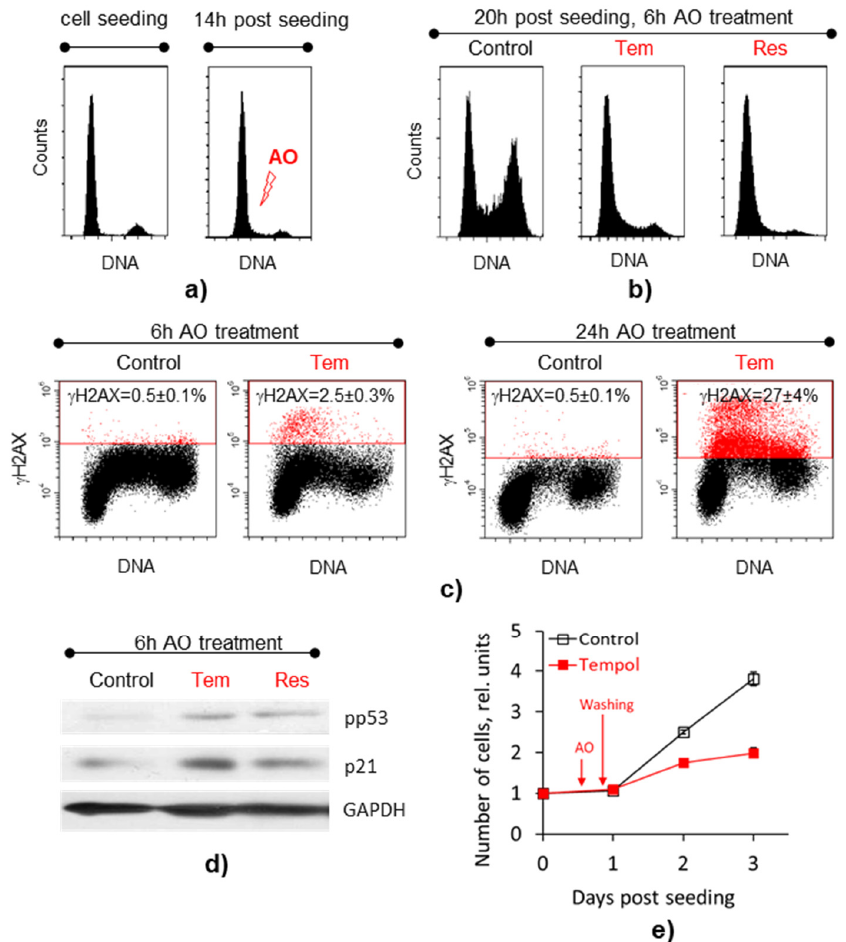
Figure 1. Cells treated with antioxidants in the early S phase slow down the DNA synthesis, accumulate DNA damage and lose proliferation capacity: ( a ) cell cycle distributions of synchronized MSCs at the moment of proliferation stimulation by reseeding (left panel) and at the moment of AO supplementation (right panel); ( b ) cell cycle phase distributions of the control MSCs and MSCs exposed to AOs for 6 h; ( c ) representative dot plots of the cell cycle distributions of MSCs stained with γ H2AX antibodies after 6-h and 24-h incubations with Tempol ( γ H2AX-positive cells are marked with red color); ( d ) Western blot analysis of the pp53 and p21 protein expression after 6-h AO treatment; ( e ) cell growth curves for control MSCs, as well as MSCs incubated with Tempol for 6 h and then washed. Data ( c , e ) are shown as mean ± SD ( n = 3). Abbreviations: antioxidants (AO), namely Tempol (Tem) and resveratrol (Res); human mesenchymal stem cells (MSCs), line#2804.